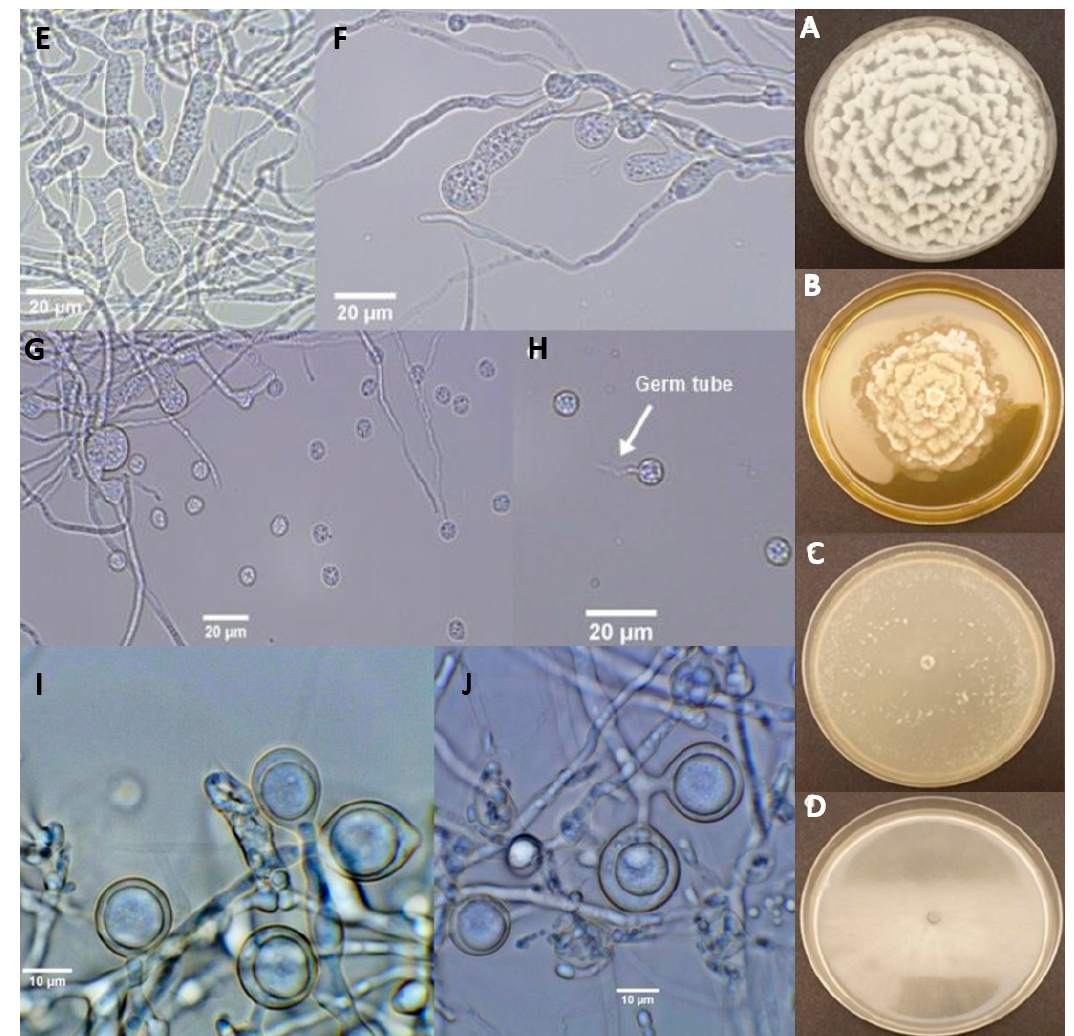
Figure 2. Growth characteristics of Pythium kashmirense . Growth on ( A ) potato dextrose agar, ( B ) malt extract agar, ( C ) 10% clarified V8 Agar and ( D ) 10% carrot agar after seven days of incubation at 25 °C in the dark. Asexual structures of Pythium kashmirense : ( E–G ) large and inflated sporangia and ( G , H ) encysted zoospores; ( H ) Encysted zoospore with an emerging germ tube; ( I , J ) Sexual structures (immature oogonia with plerotic oospores) of Pythium kashmirense .